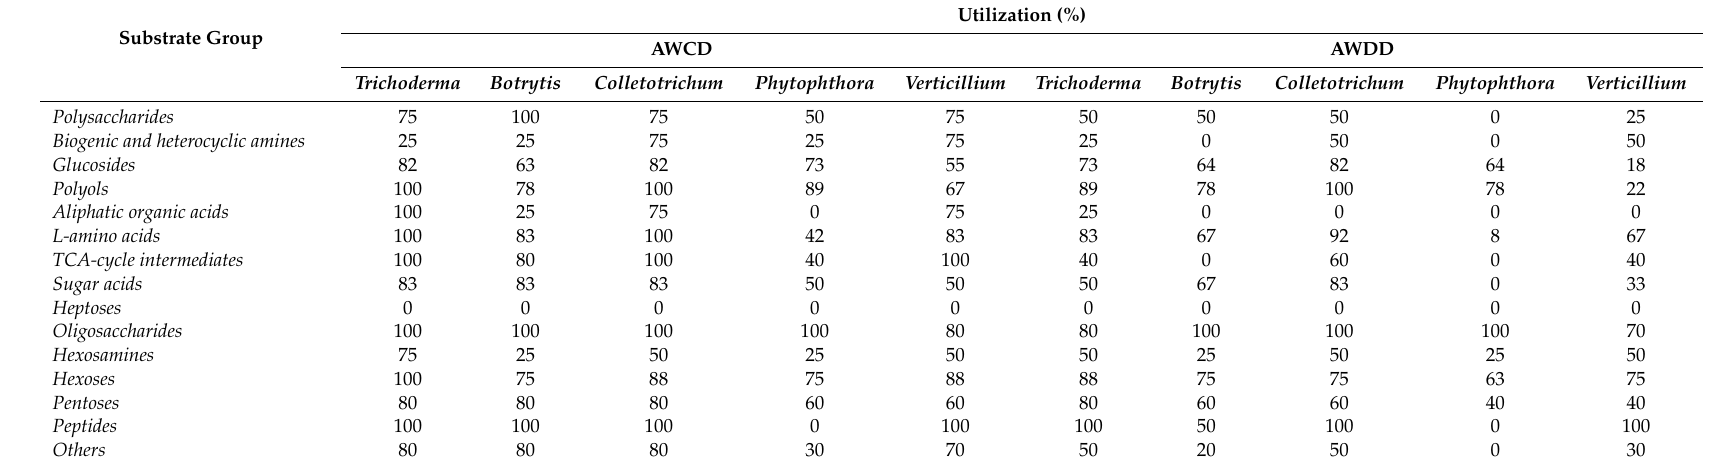
Table 2. The share of FF Biolog ® substrate group positive response (%) of the pathogenic fungi and beneficial Trichoderma strains, calculated on the basis of consumption (Average Well Colour Development—AWCD, 490 nm) and growth (Average Well Density Development—AWDD) potentiates (A > 0.2, n = 3). Substrate